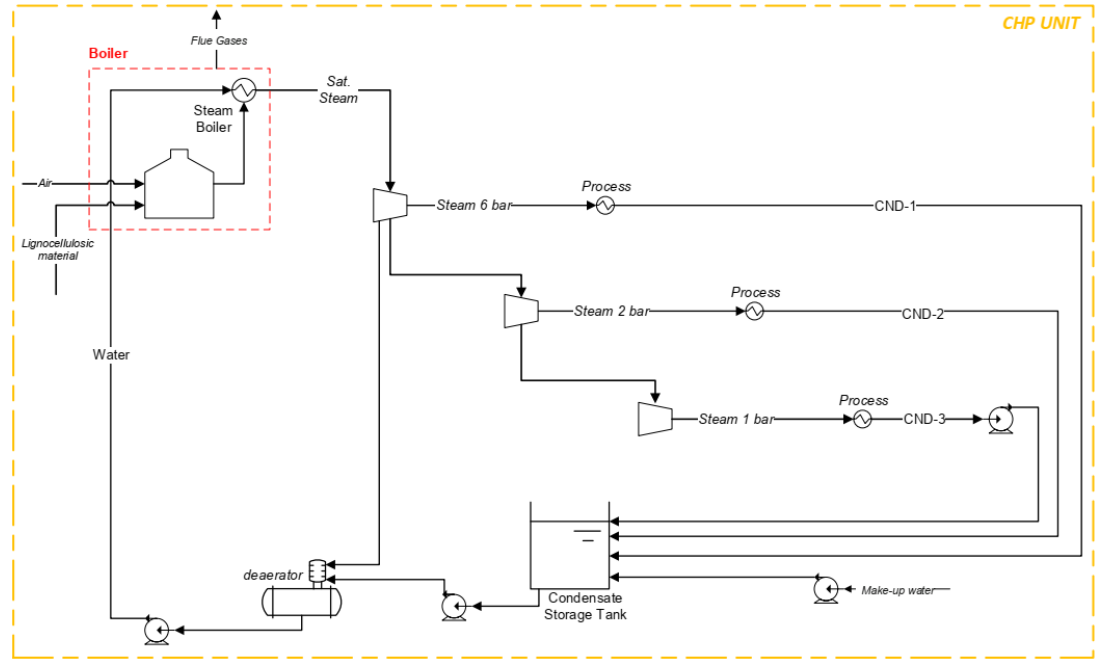
Figure A3. Process flow diagram of the utility system.